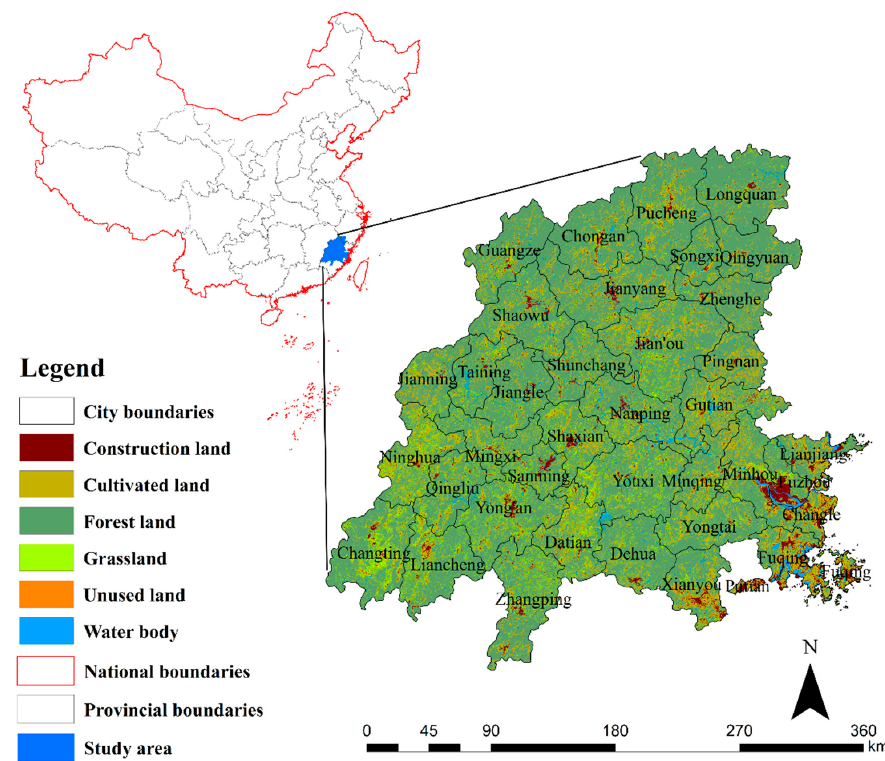
Figure 1. Geographical location and land use of the Minjiang River Basin.